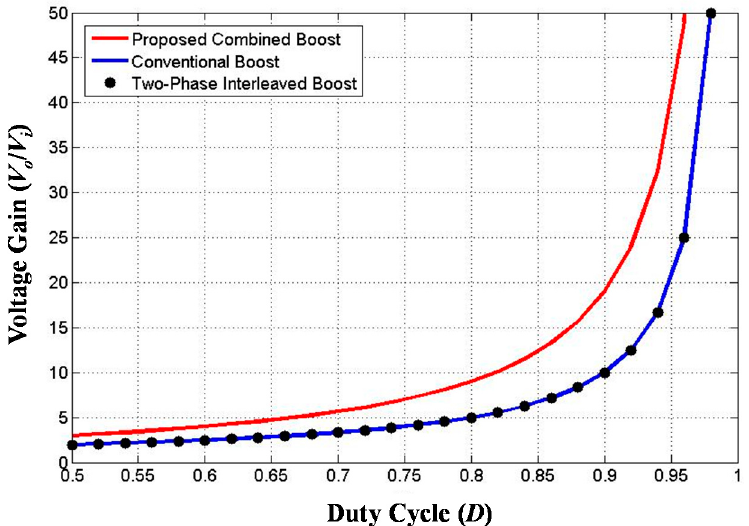
Figure 5. The comparison of the voltage gains produced by the proposed combined boost converter, the conventional boost converter, and the interleaved boost converter with two-phases.